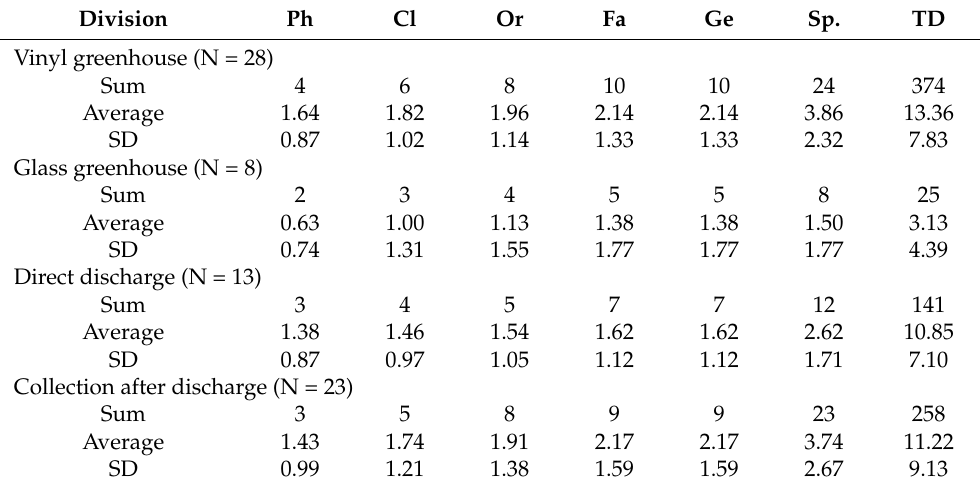
Table 3. Fungi detected according to the type of greenhouse and drainage.